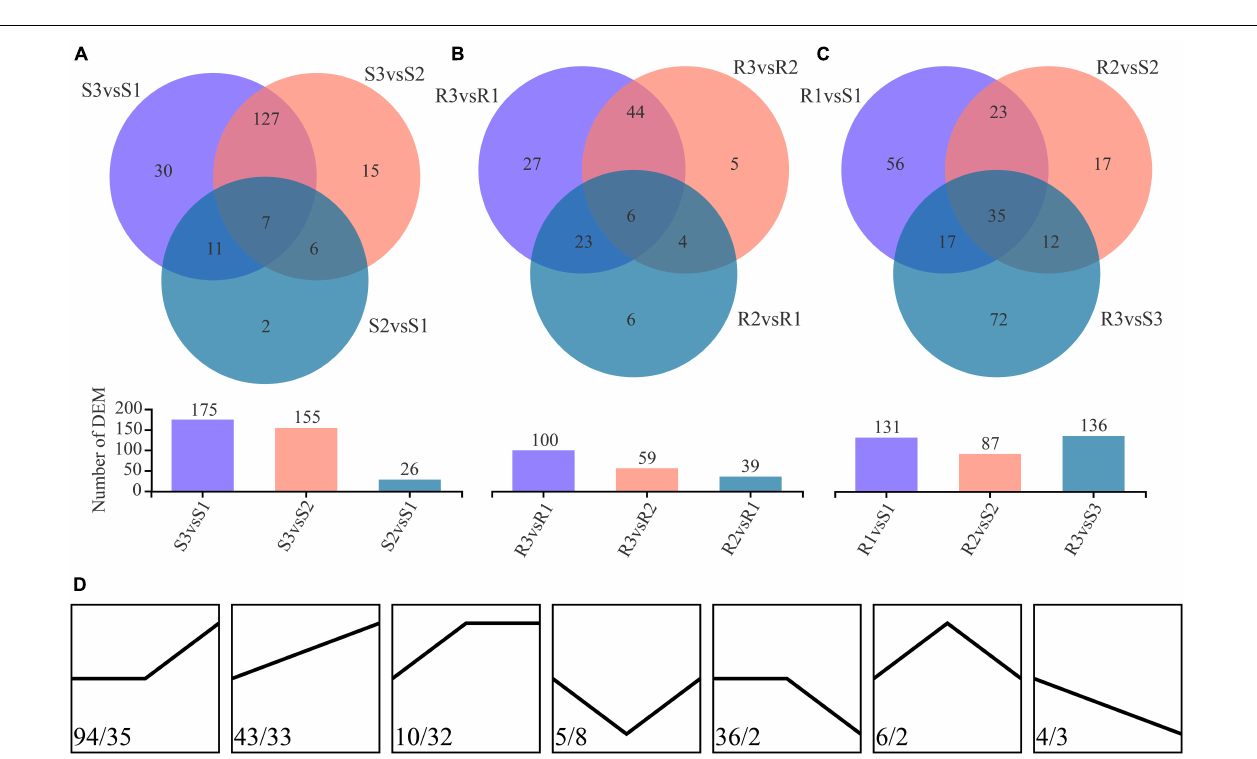
FIGURE 2 | Correlation analyses of the different samples collected from the compatible and incompatible interactions. (A) Sample correlation Partial Least Squares-Discriminant Analysis (PLS-DA) diagram. (B) Sample correlation heatmap. R1, R2, and R3 represent the samples collected at 0, 48, and 96 hpi, respectively, in incompatible interactions. S1, S2, and S3 denote the samples collected at 0, 48, and 96, respectively, in the compatible interactions. QC, quality control sample.